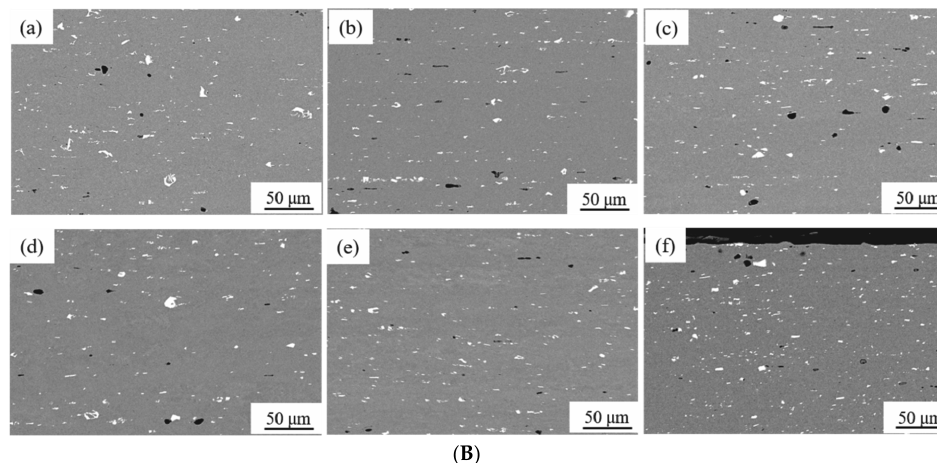
Figure 2. SEM images of the as-annealed and cold-rolled AA6061 alloy showing the dark and bright particles; ( A ) surface region, and ( B ) center portion; ( a ) as-annealed, ( b ) Δt/t 0 = 10%, ( c ) Δt/t 0 = 30%, ( d ) Δt/t 0 = 50%, ( e ) Δt/t 0 = 70%, and ( f ) Δt/t 0 = 90%.